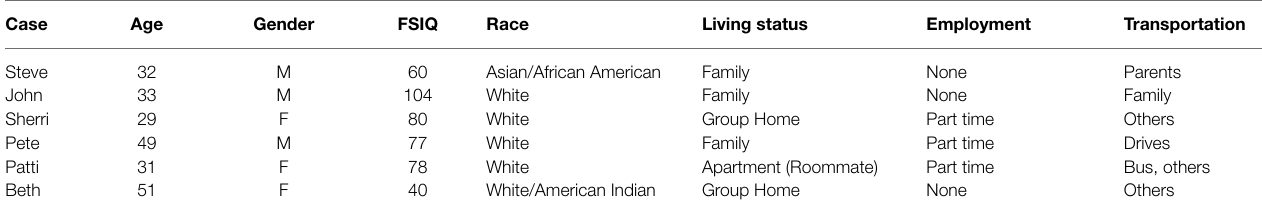
TABLE 1 | Demographic